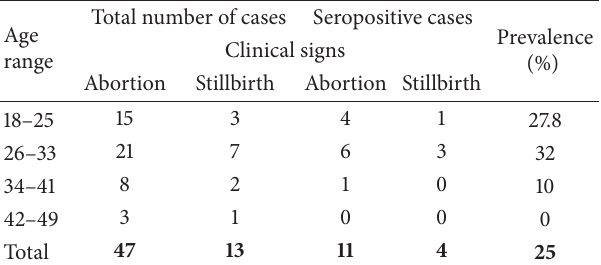
Table 1: Prevalence of Brucella seropositivity by age group and clin- ical presentation.